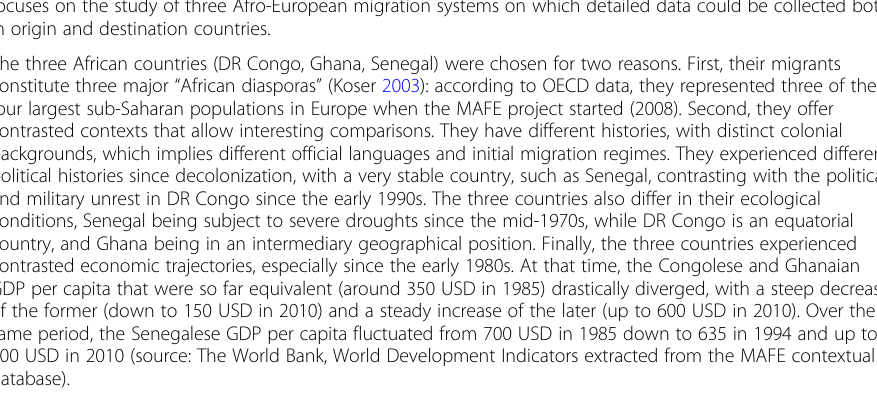
Table 1 Three Sub-Saharan migration